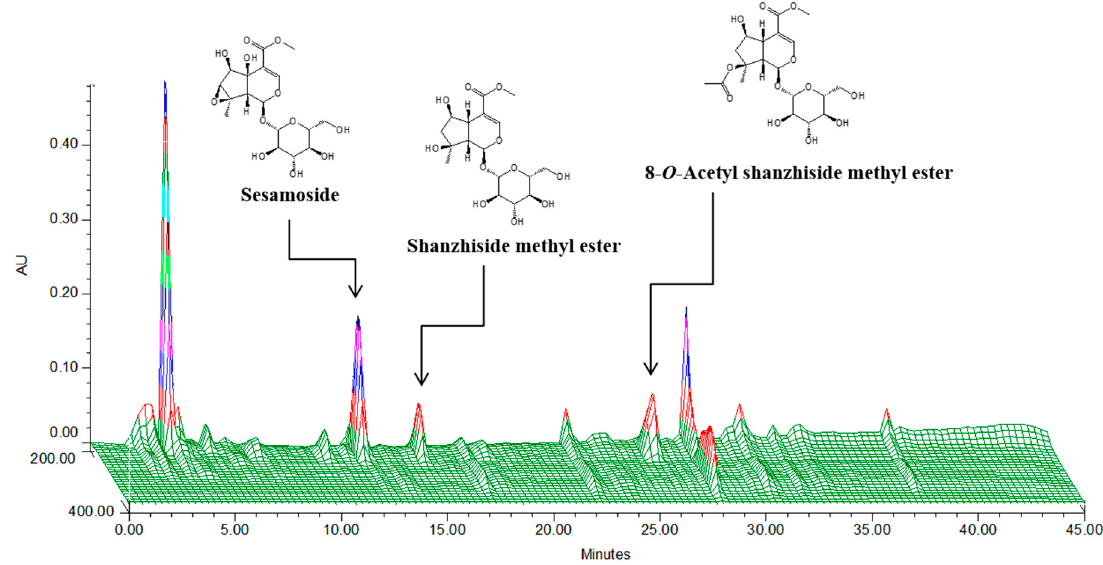
Figure 1. Three-dimensional high-performance liquid chromatogram for standardization of P. umbrosa.